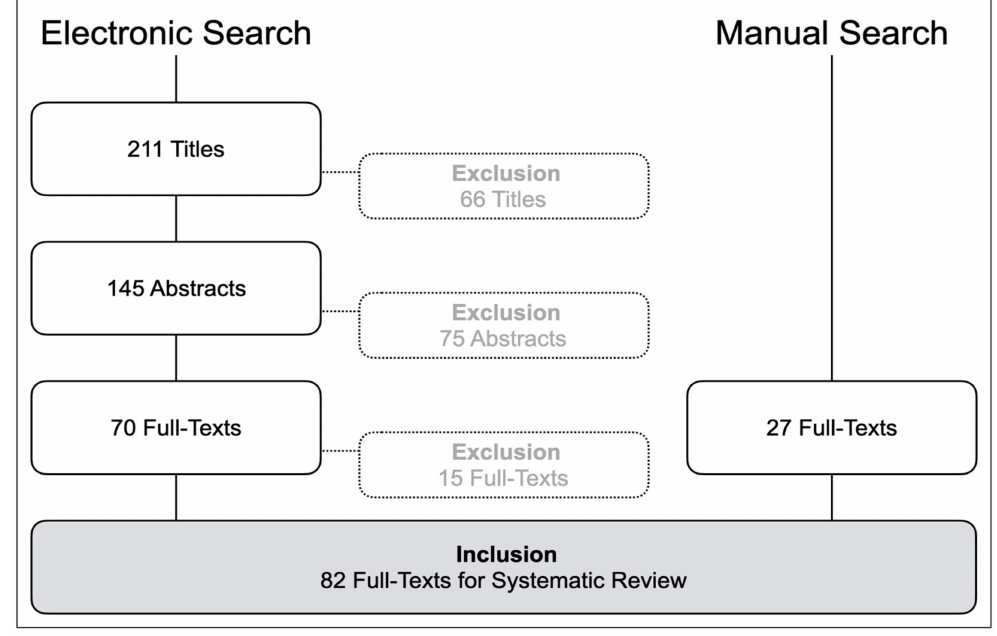
Figure 1. Systematic search